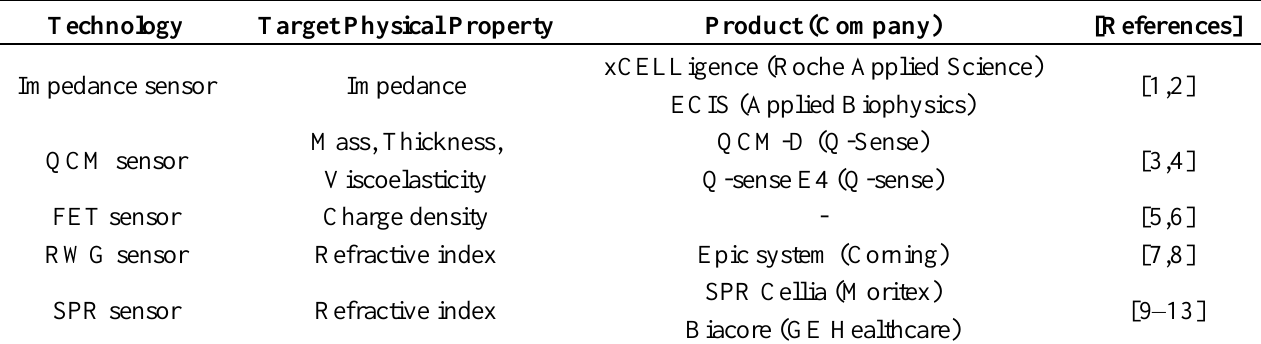
Table 1. Biosensors for living cell